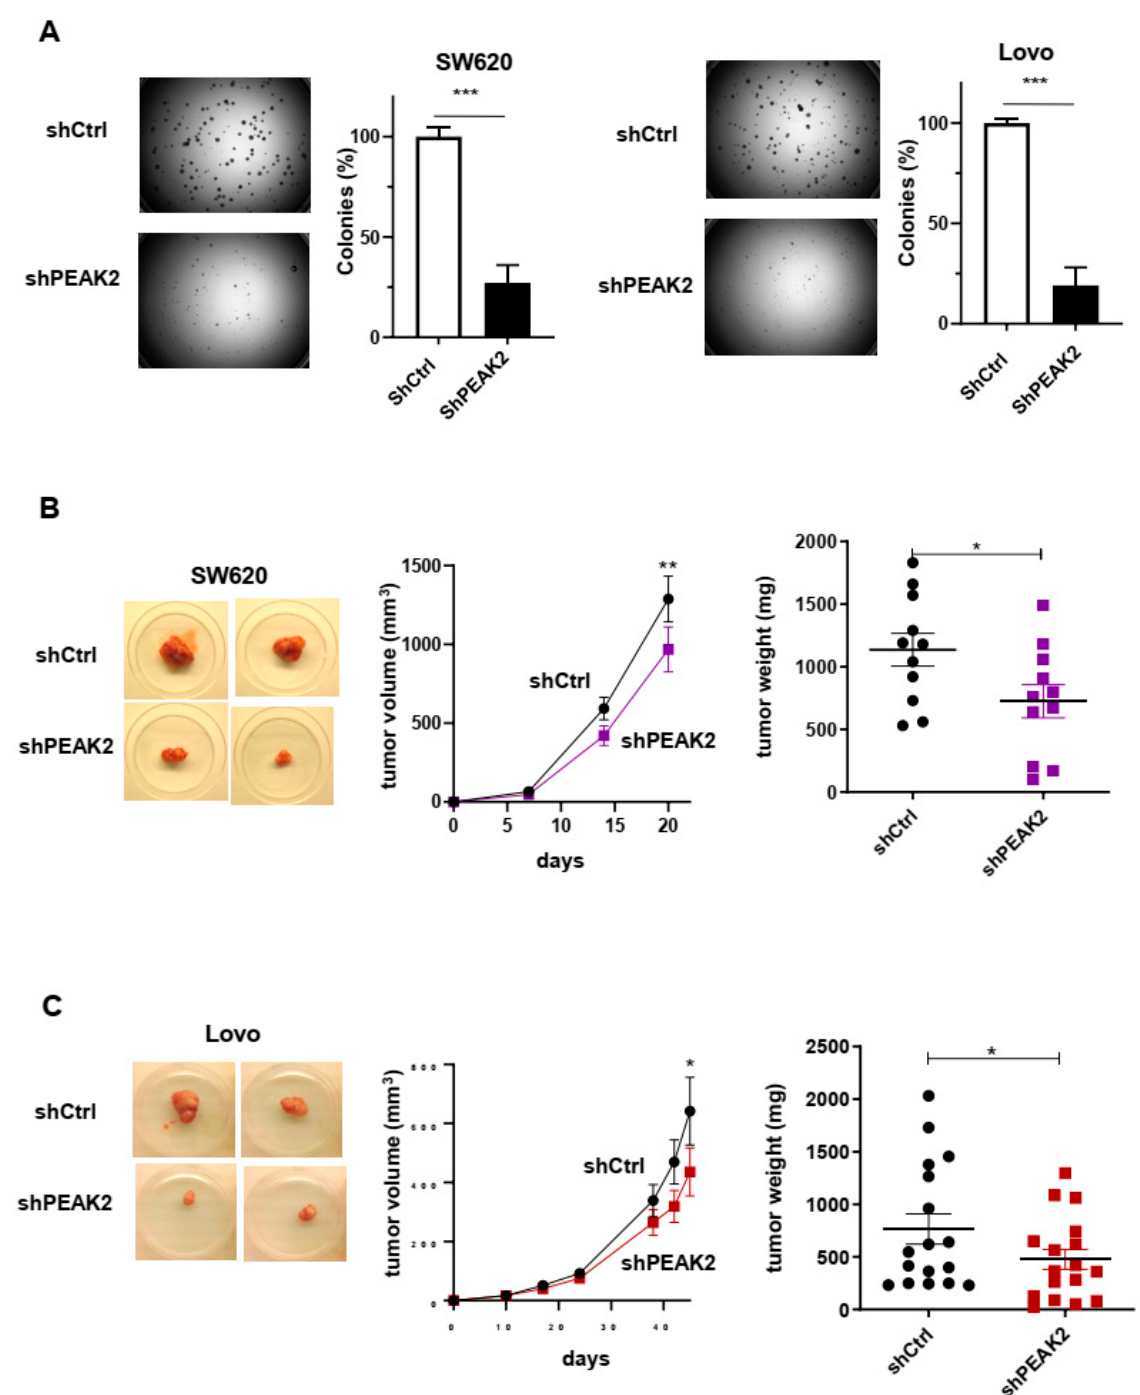
Figure 3. PEAK2 depletion reduces CRC cell growth and tumour development. ( A ) Anchorage-independent growth in soft agar of CRC cells expressing shRNA control (shCtrl) or shRNA PEAK2 (shPEAK2) (left: representative example; right: quantification of colonies obtained in soft-agar. ( B , C ) Tumour development in nude mice subcutaneously inoculated with indicated CRC cells that were transduced with shRNA control (shCtrl) or shRNA PEAK2 (shPEAK2). Is shown a representative example of tumours obtained in nude mice, the time-course of tumour development (volume) and the tumour mass; mean ± SEM from 13 ( B ) and 17 ( C ) mice per condition (* p < 0.05; ** p < 0.01; *** p < 0.001) (Student’s t